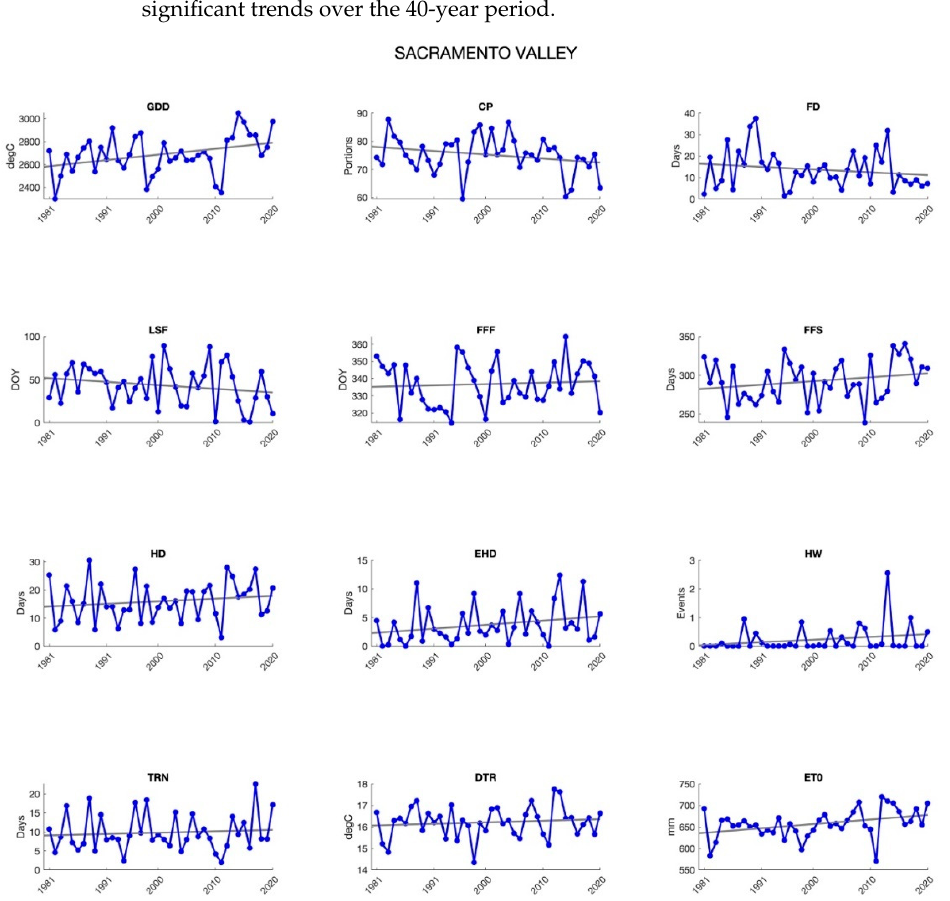
(DTR), summer reference evapotranspiration (ETo). GDD, HD, EHD, HW, and ETo have statistically